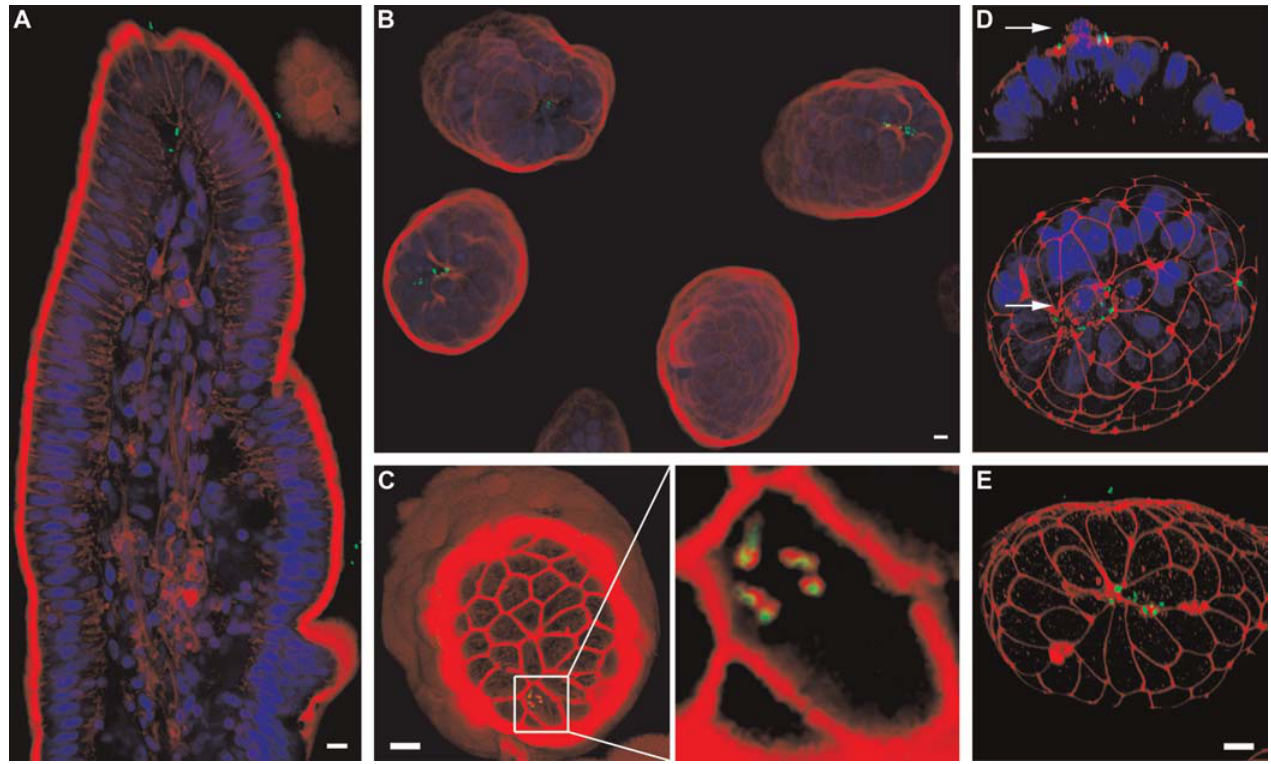
Figure 7. L. monocytogenes Invasion of the Intestinal Epithelium at the Villus-Tip Extrusion Zone (A) Optical longitudinal section through a villus tip from Wt-GFP L. monocytogenes infected rabbit intestinal tissue stained with phalloidin for F-actin (red) and with toto-3 for nuclei (blue). GFP-expressing bacteria are shown in green. (B) Three-dimensional reconstruction of villus tips viewed from the lumenal side from tissue stained as in (A). (C) Optical cross-section through three-dimensional reconstruction of a villus tip revealing intracellular L. monocytogenes (green). F-actin (red) is stained with phalloidin. Right: enlarged view of infected cell revealing actin nucleation on the surface of Wt-GFP L. monocytogenes . (D) Three-dimensional confocal reconstruction of villus tip from tissue stained with antibodies to ZO-1 (red) and with toto-3 for nuclei (blue). Arrow indicates a cell being extruded. (E) Three-dimensional reconstruction of infected villus tip stained with antibodies to ZO-1 (red), showing a multicellular junction. Scale bars 10 l m. DOI: